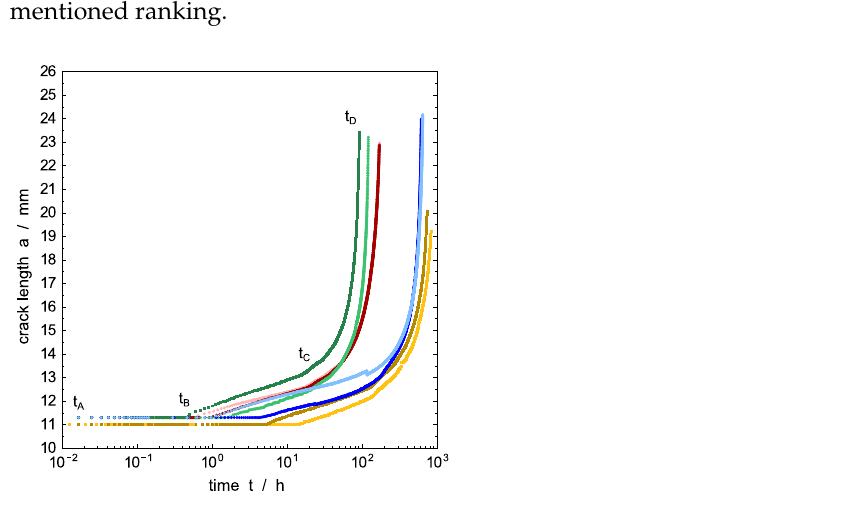
Figure 5. Calculated average crack length as a function of time for different environmental media at 40 °C media temperature. PFL-FR 2323 (yellow), PFL-FR 2344 (green), distilled water (blue), 2 wt% aq. Arkopal N100 (red). Different color shading represents the individual experiments performed per medium. Characteristic time used in the discussion is defined at the green curve for PFL-FR 2344. In the initial time interval 𝑡 (cid:3002)(cid:3003) no crack growth could be detected, as shown in Figure